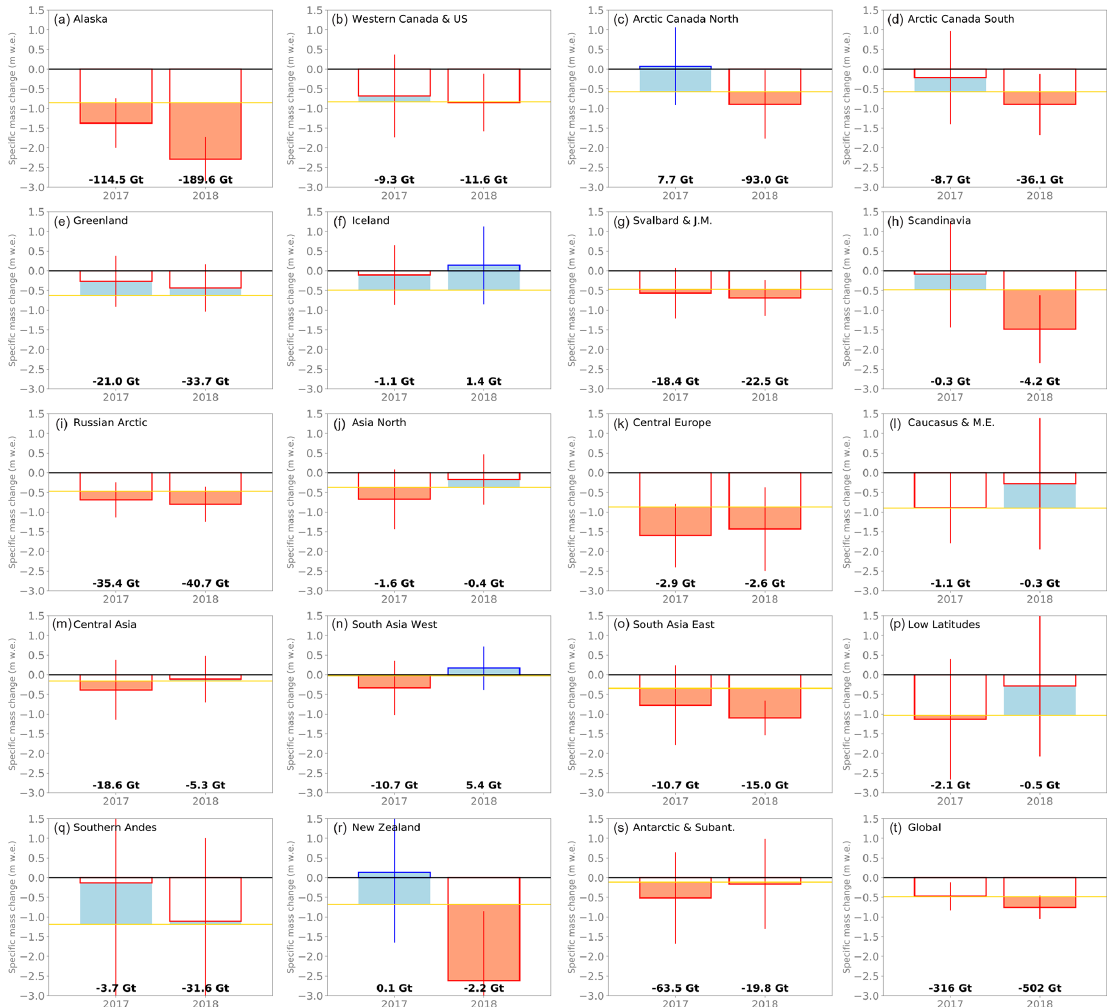
Figure 1. Ad hoc estimates of regional mass changes in 2016/17 and 2017/18. The regional (a–s) and global (t) bar plots show the annual specific mass changes (in mw.e.) with related error bars (indicating 95% confidence intervals), with positive and negative values in blue and red, respectively. The golden line indicates the annual mass-change rate of the reference data (in mw.e.yr − 1 ; Zemp et al., 2019) over the calibration period (2006/07–2015/16). Positive and negative annual mass-change anomalies (with respect to reference data and calibration period) are indicated in pale blue and pale red, respectively. The black values (bottom) indicate annual mass changes in gigatonnes. Plots are ordered from top left to bottom right according to the region numbers in RGI 6.0 (see Table